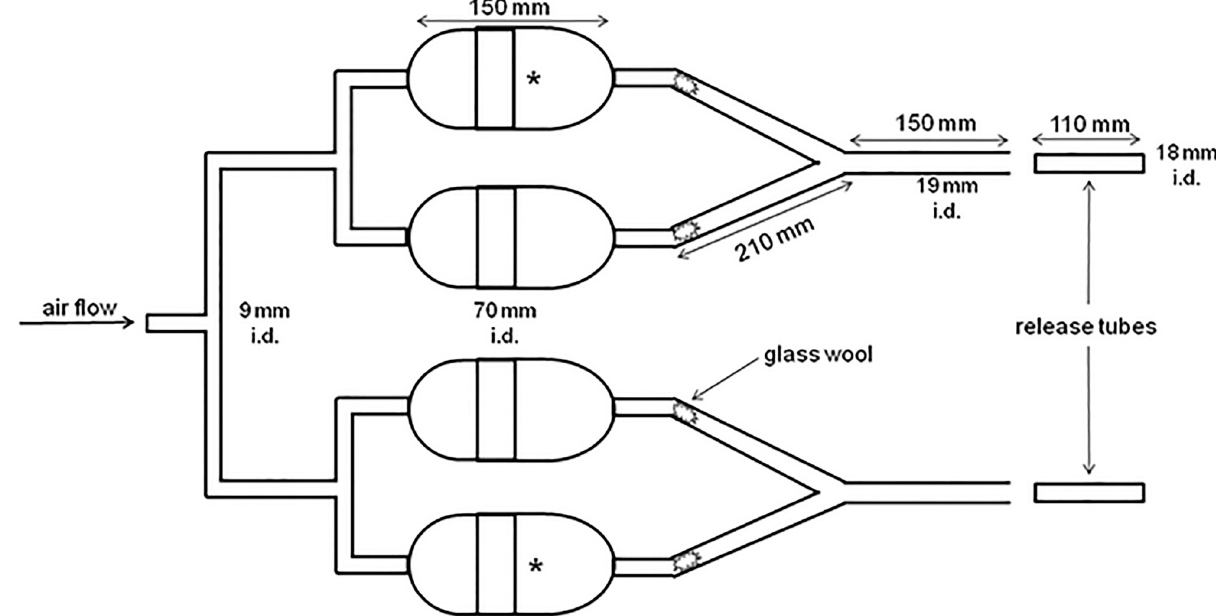
Fig 2. Illustration of the use of a Y-tube olfactometer to evaluate the attractiveness of infected and uninfected mice to Ny . neivai . � Initial position of the mouse. Arrows indicate release tubes in which female sand flies were placed.